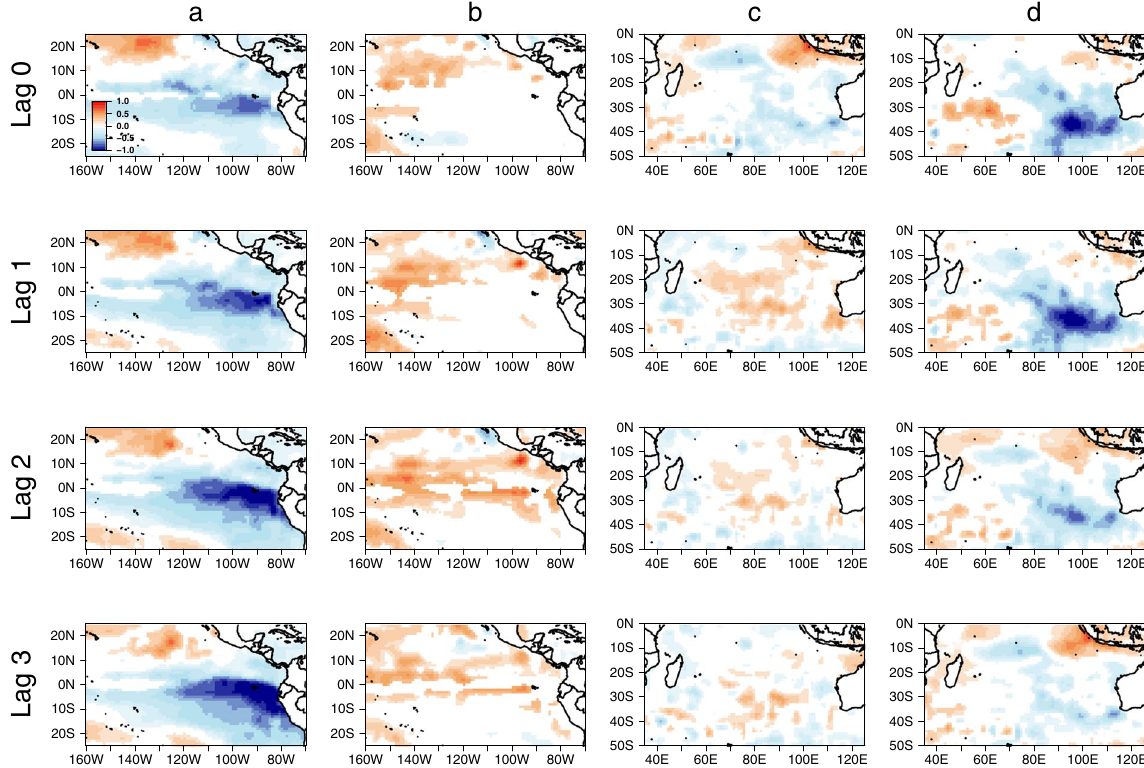
Figure 6. Composites of SST (°C) in the tropical eastern Pacific for ( a ) SON and ( b ) DJF. Likewise for the Indian Ocean for ( c ) SON and ( d ) DJF. Differences in composite anomalies between the high and low malaria incidence years are shown. Rows associate to lags of zero to three months. Composites at 90% confidence level are shown. Figure was made in R version 3.2.2